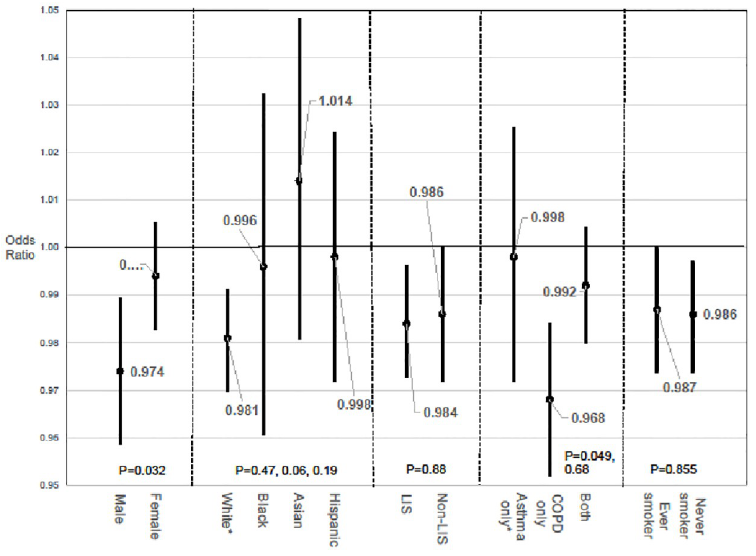
Fig 1. Incidence of Parkinson’s disease associated with β 2-agonist use (30-day claims) by subgroup. P values at bottom are for within-group comparisons. For groups with more than two categories, P values are in relation to reference groups denoted by � in axis